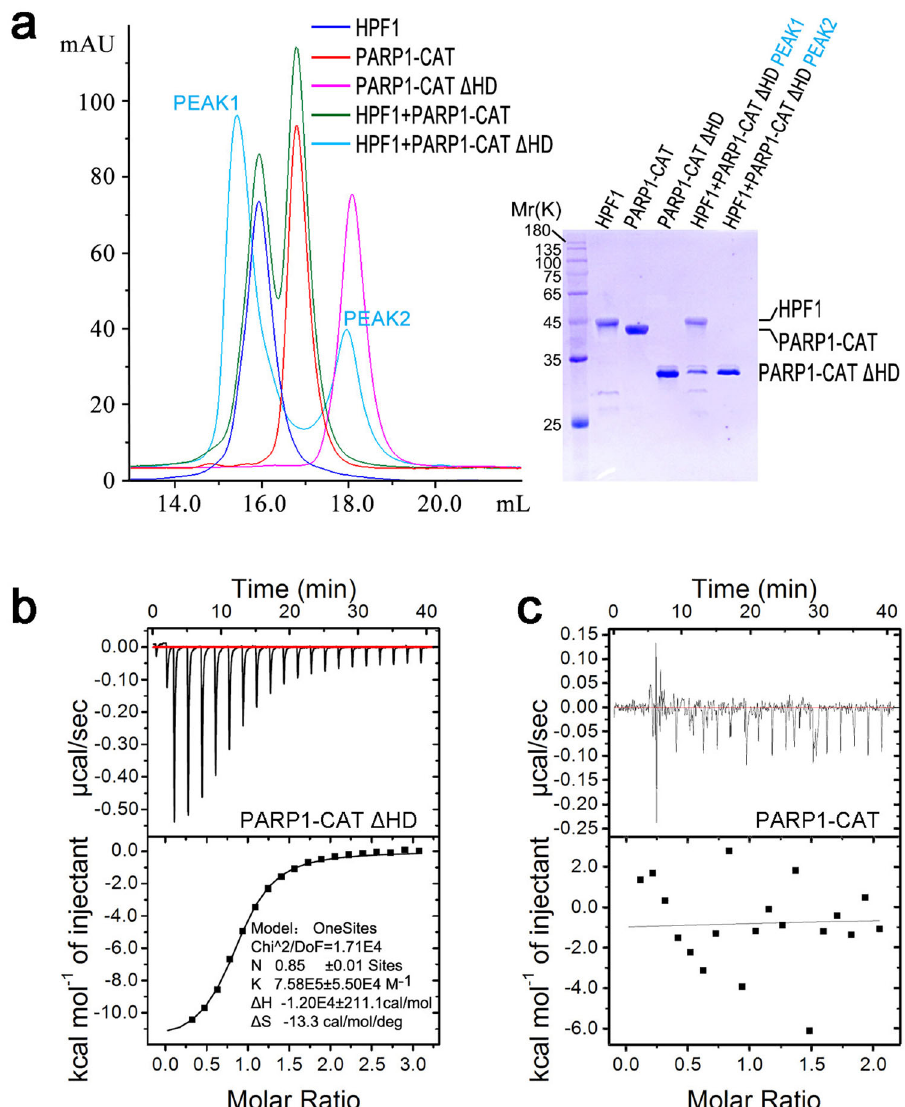
Fig. 1 HPF1 binds to PARP1-CAT Δ HD. a The SEC assay indicated that HPF1 binds to PARP1-CAT Δ HD, but not full-length PARP1-CAT. b Typical ITC data where human HPF1 was titrated into a solution of PARP-1 CAT Δ HD. In this titration, the association constant ( K ) of HPF1/PARP-1 CAT Δ HD was estimated to be 7.58E5± 5.50E4 M -1 , equivalent to a dissociation constant ( K d ) of ~1.3 μ M. After replicated measurements, the fi nal K d value was determined to be 1.5 ± 0.2 μ M (Table 1, Supplementary Fig. 2). c Typical ITC data where human HPF1 was titrated into a solution of full-length PARP-1 CAT. No binding was detected in this